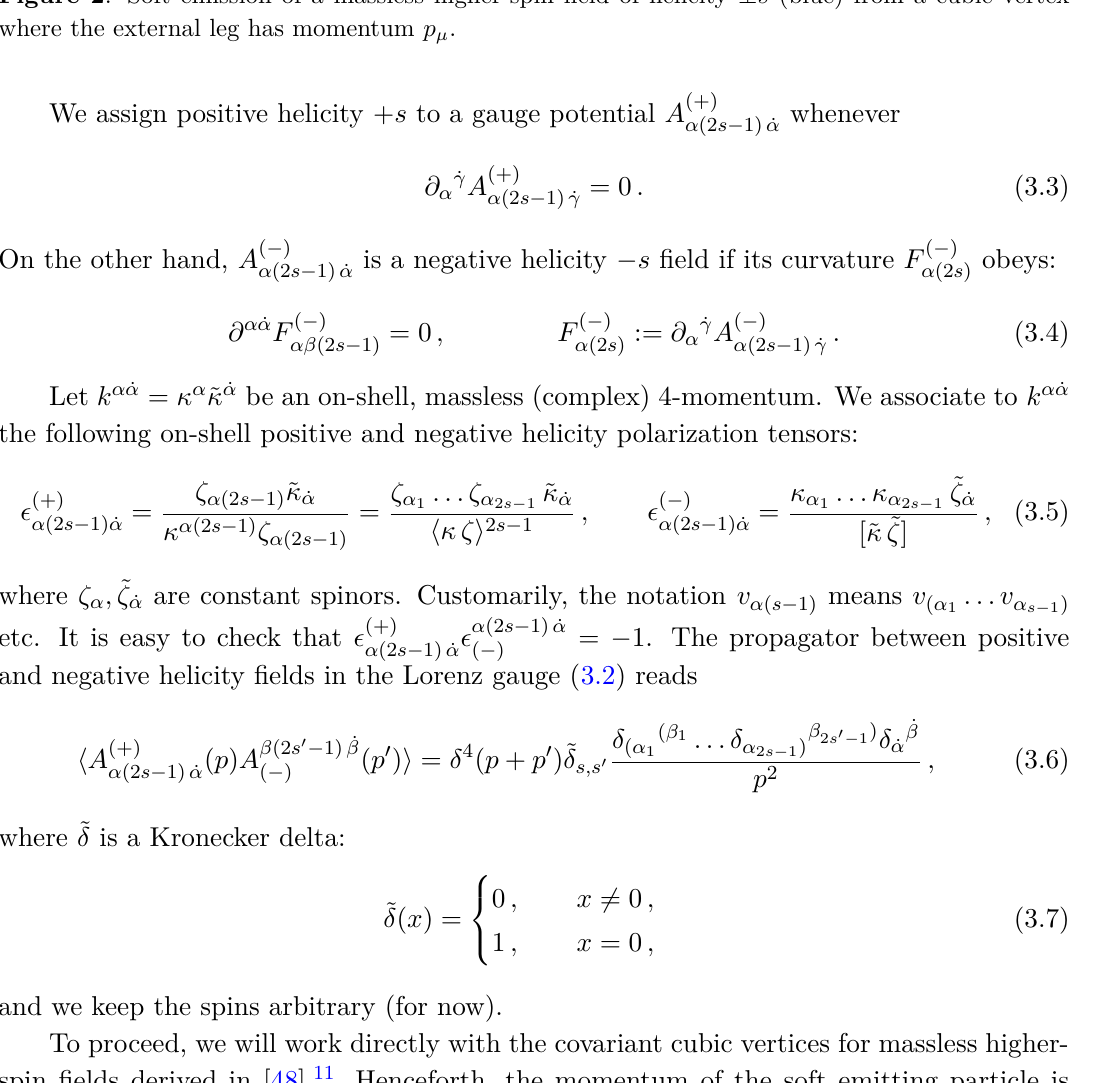
Figure 2 . Soft emission of a massless higher-spin field of helicity ± s (blue) from a cubic vertex where the external leg has momentum p µ